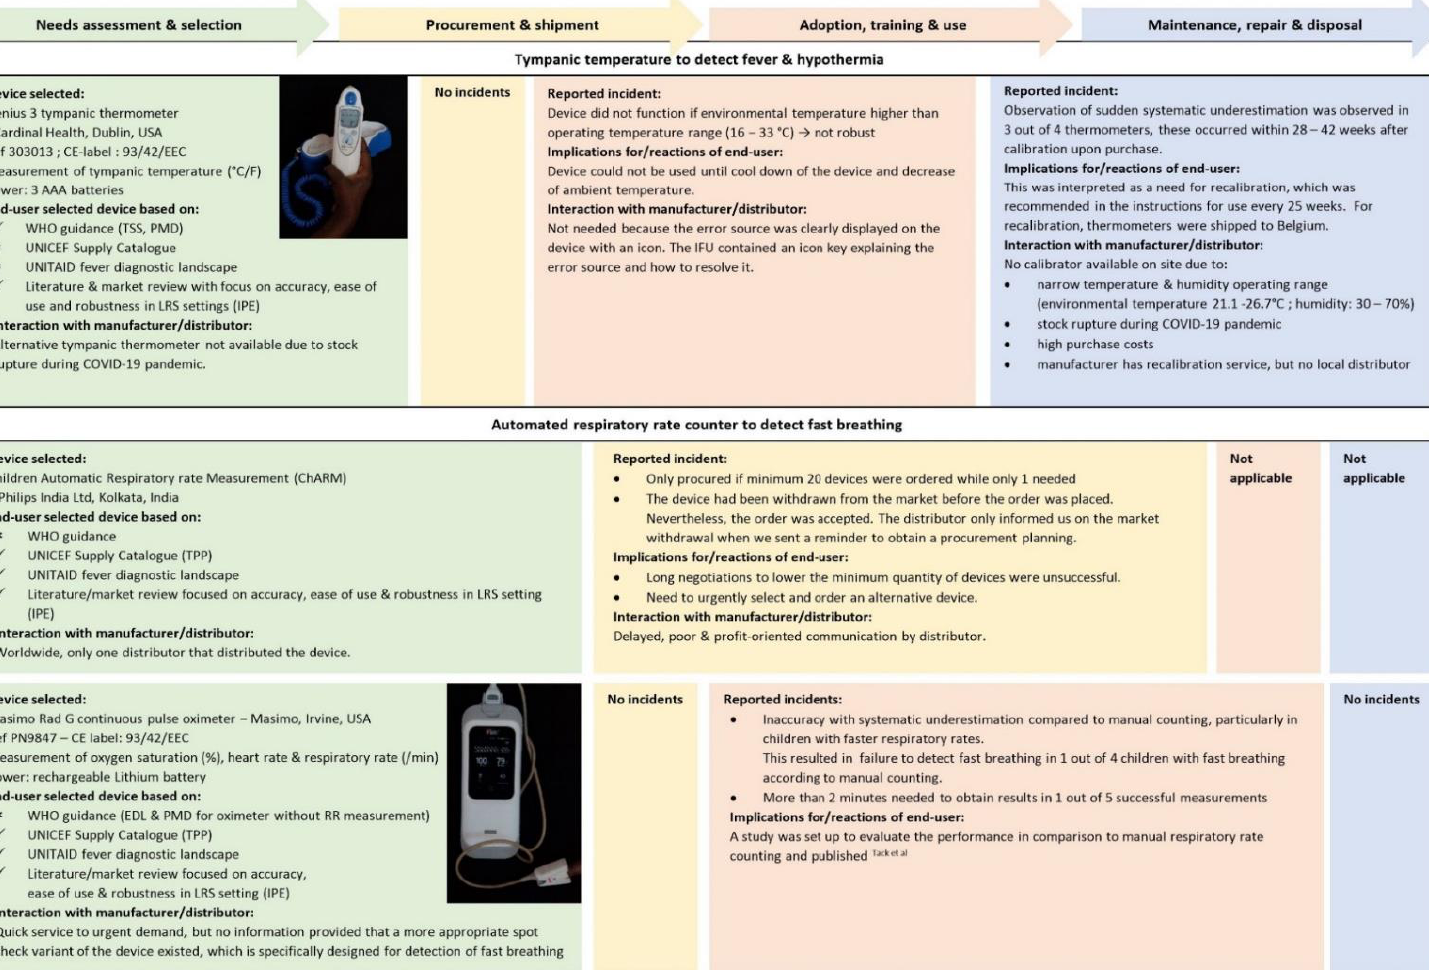
Figure 3. Field experiences reported by end-users during the lifecycle of handheld diagnostic devices to measure tympanic temperature and respiratory rate. Abbreviations and references: IPE: Independent Product Evaluations [38 – 49], PMD: WHO Priority Medical Devices [23], TPP: Target Product Profile [50], TSS: WHO Technical Specification Sheet [24], Tack et al. [28].